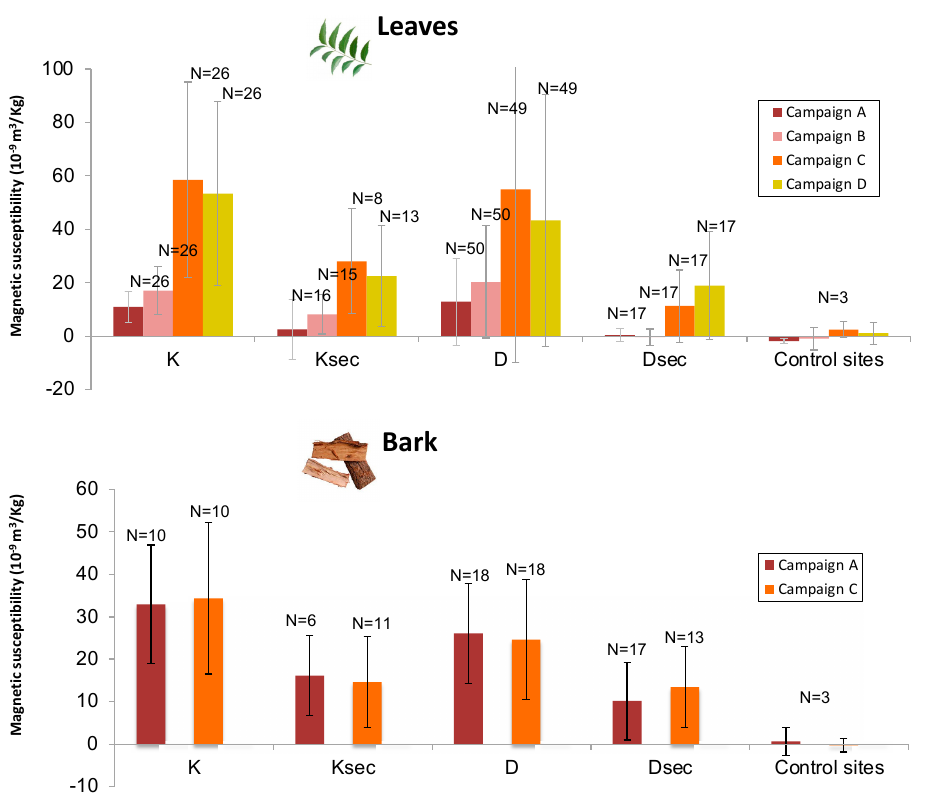
Figure 3. Mean leaf and bark mass magnetic susceptibility values by sector and sampling campaign, showing the variations of magnetic susceptibility on leaves as a function of the season and the stability of the bark’s values. K is Avenue Kakataré and D, Boulevard du Renouveau. Ksec and Dsec refer to secondary streets crossing perpendicularly K and D, respectively (see Figures 1 and 2 for localization). Error bars represent the standard deviation, N the number of data.